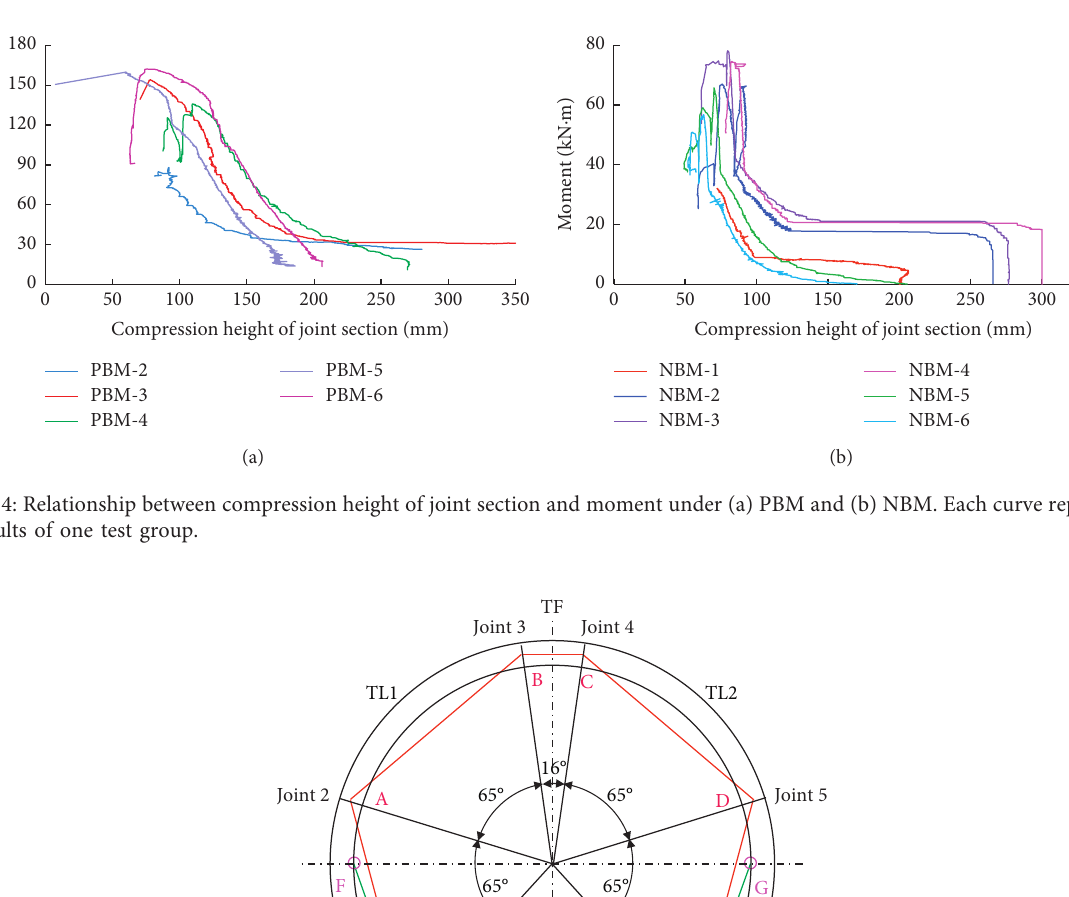
Figure 3: Relationship between joint opening angle and moment under (a) PBM, group PBM-6, and (b) NBM, group NBM-6. Method 1 in the legend represents the sum of the rotation angles of the two adjacent segments. Method 2 represents the joint opening angle calculated by Equation (1).